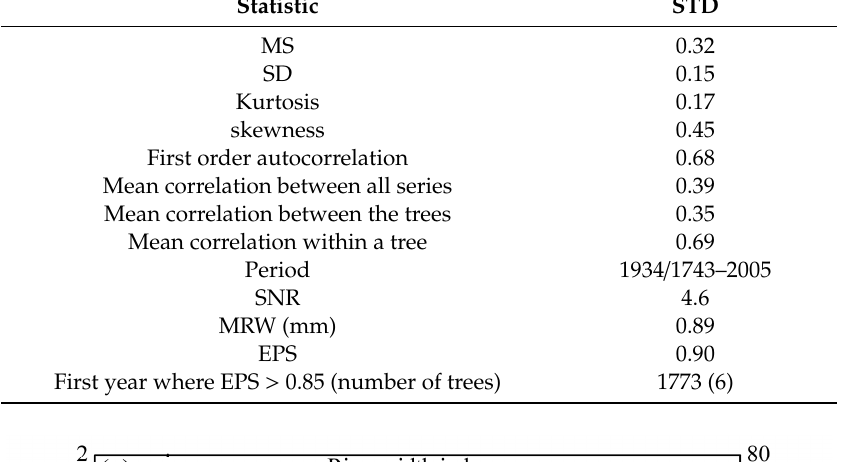
Table 1. Statistical features of STD chronology.